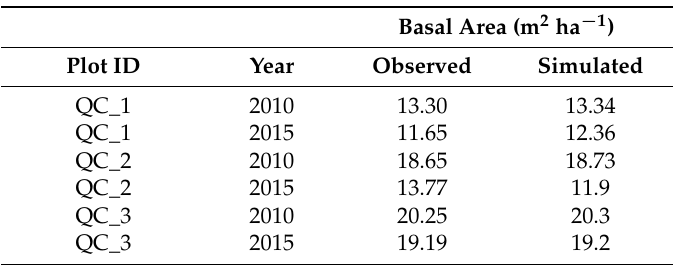
Table A1. Calibration results for TRIPLEX-Insect model using basal area data during the 2010–2016 from the North Shore region of Qu é bec.